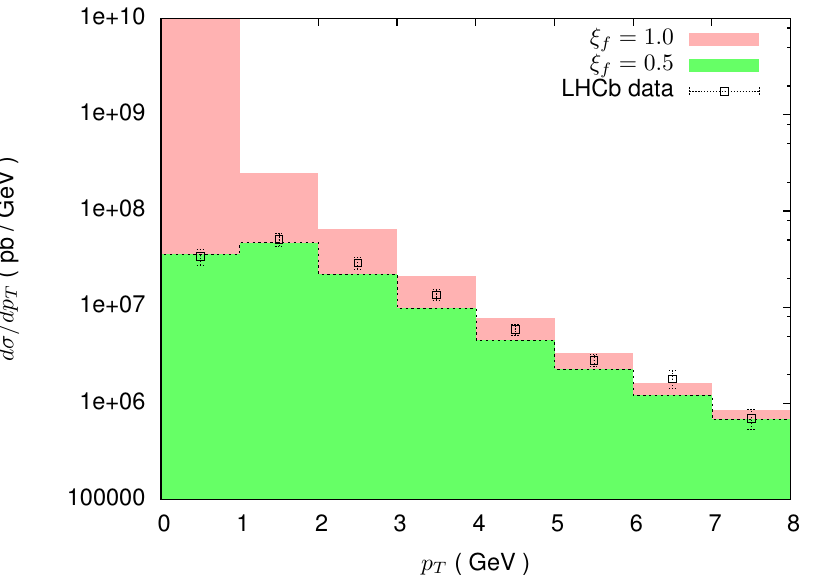
Figure 1 . ( D + + D (cid:0) ) di(cid:11)erential cross sections d (cid:27) /d p T in pp collisions at 7 TeV in the 3 : 0 < y < 3 : 5 rapidity range. The histograms correspond to the choices (cid:22) r = with (cid:24) = 0 : 5 or (cid:24) = 1 : 0. The experimental data are taken from ref.